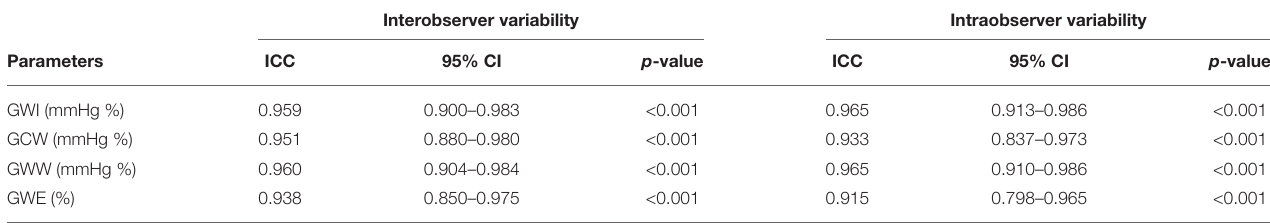
TABLE 7 | Inter- and intra-observer variability for myocardial work